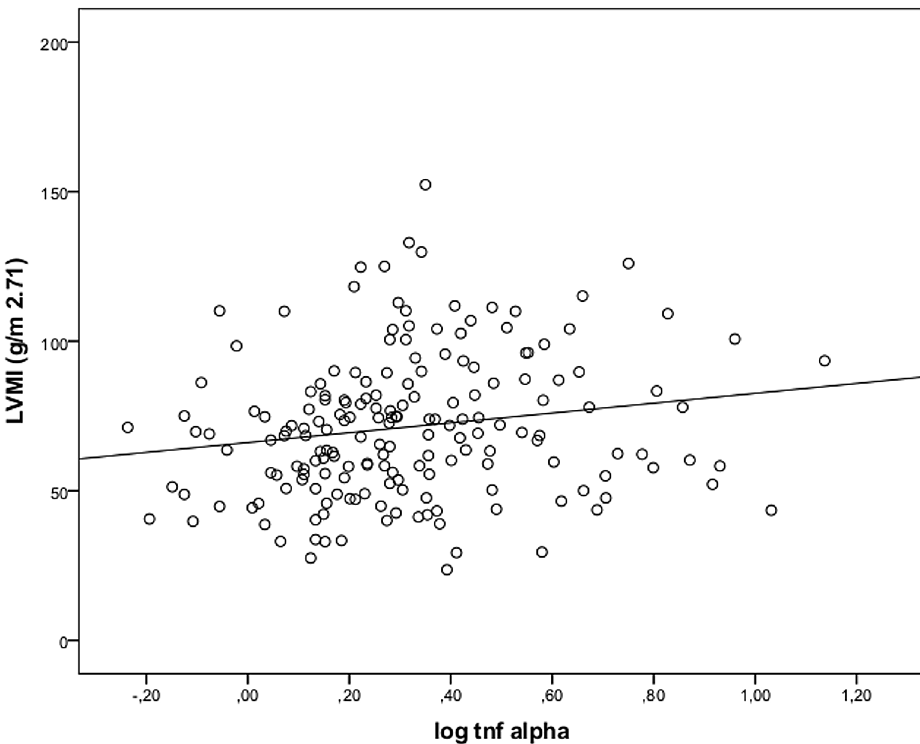
Fig 2. Correlation between log TNF- α with left ventricular mass (g/m 2 (cid:1) 71 ) (n = 182).